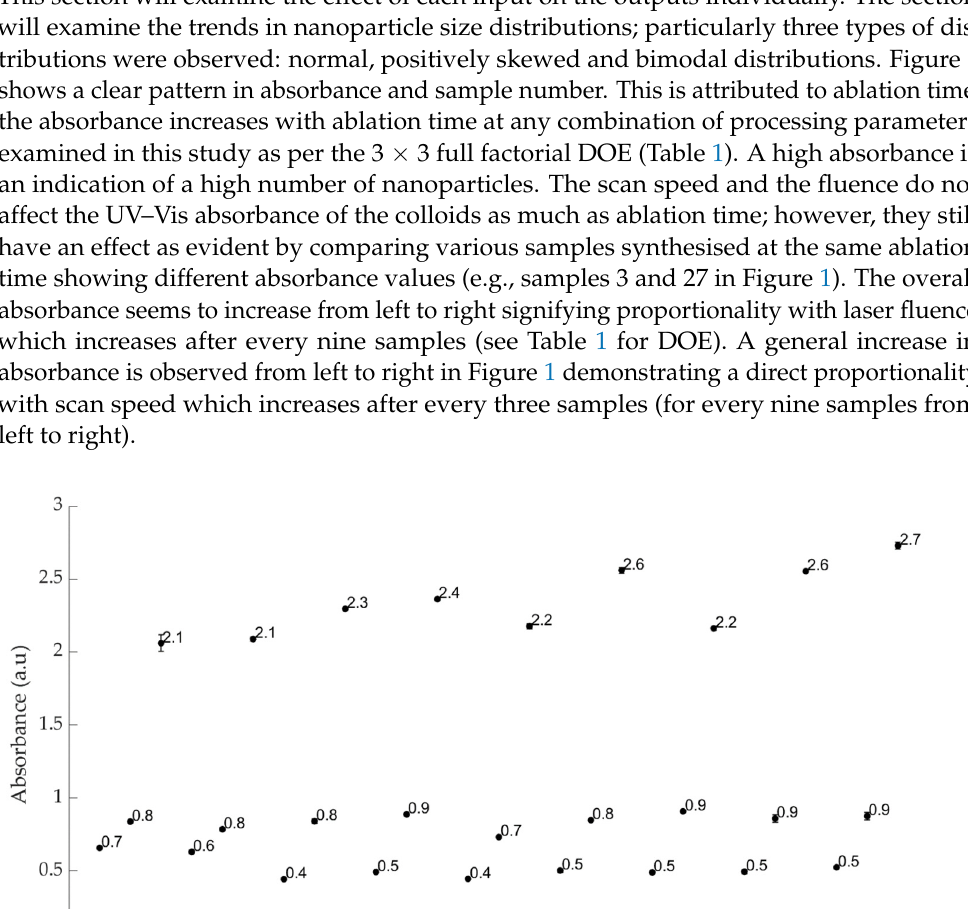
Figure 2. Mean nanoparticle diameter per sample group (1–27) (95% CI).